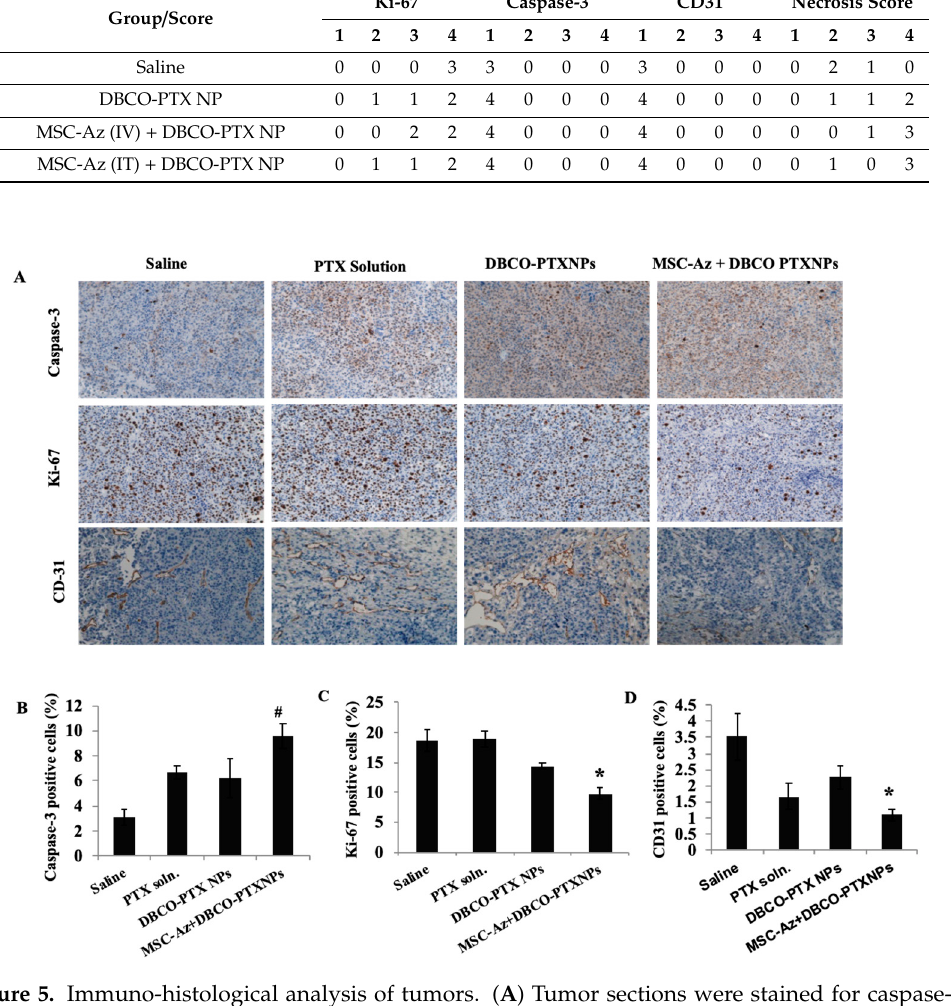
Figure 5. Immuno-histological analysis of tumors. ( A ) Tumor sections were stained for caspase-3 (apoptosis marker), Ki-67 (proliferation marker) and CD-31 (angiogenesis marker). Images were captured at 20 × magnification. Quantitative results of ( B ) Caspase-3, ( C ) Ki-67, and ( D ) CD31. Data is represented as mean ± SEM, n = 9 images; # p < 0.05 compared with saline group and * p < 0.05 compared with all treatment groups.